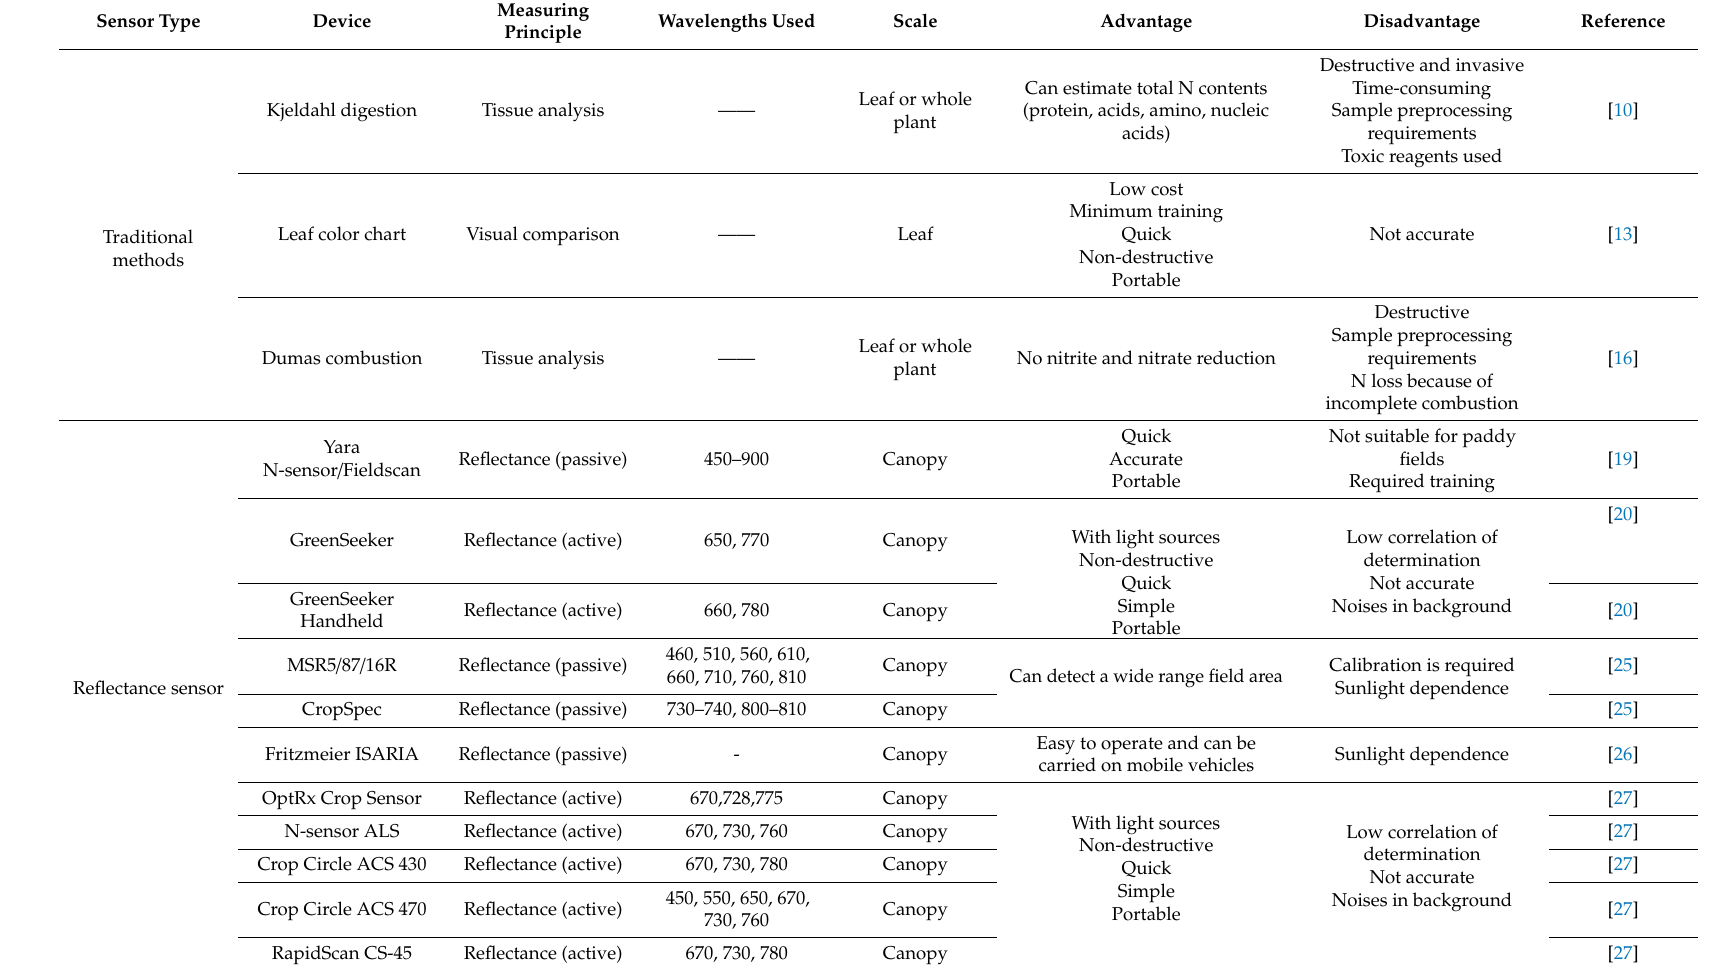
Table 1. A summary of the methods for diagnosis of N